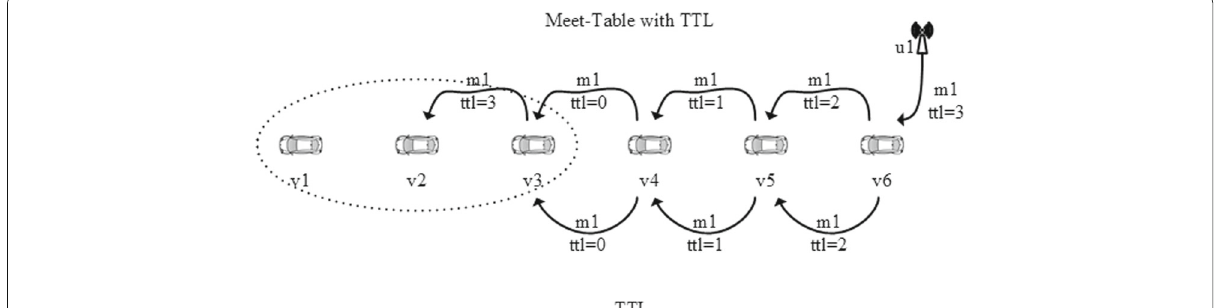
Fig. 1 Principle of enhancing negative message broadcasting with Meet-Table and